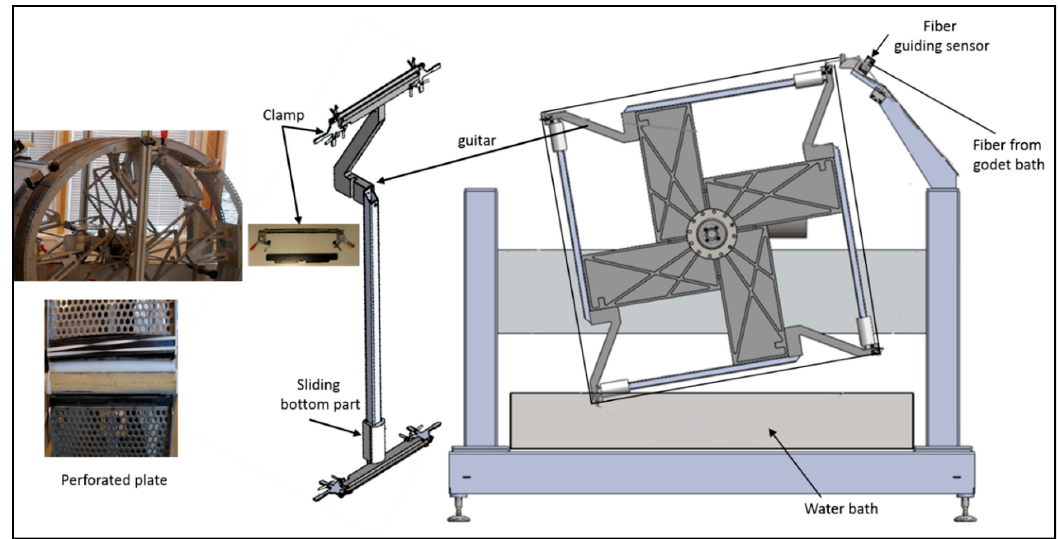
Figure 4. Collection wheel: Four fiber carriers attached to a rotating shaft (right side), perforated plate photos (left side).